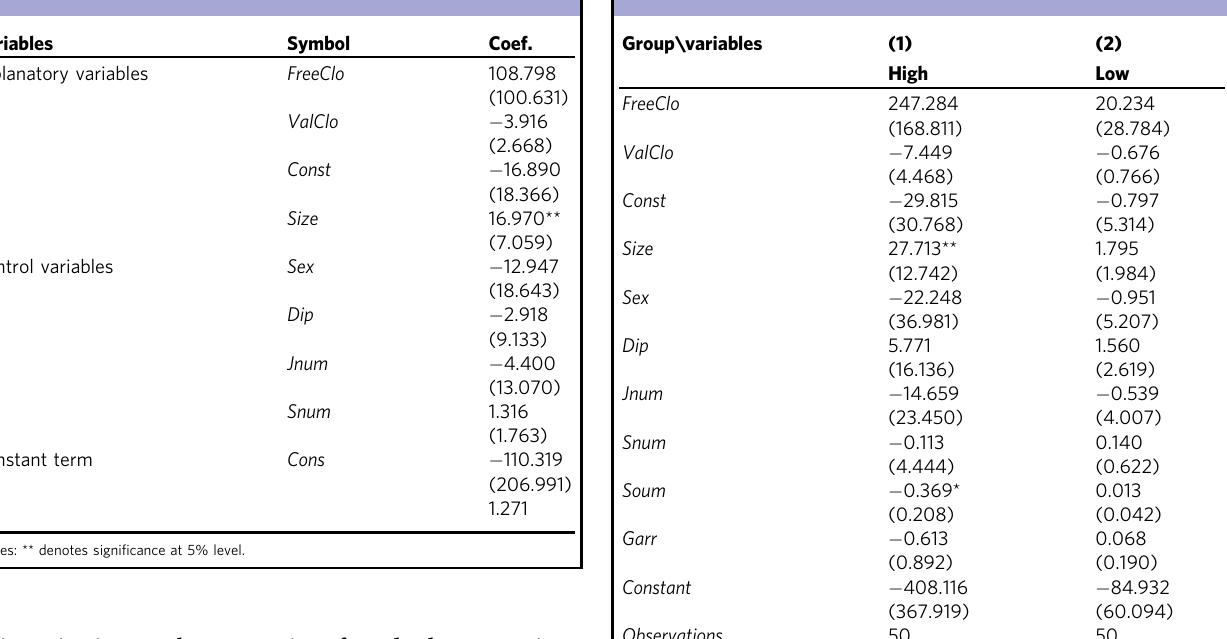
Table 4 Regression results of fund manager social network on herding behavior of SIFs.